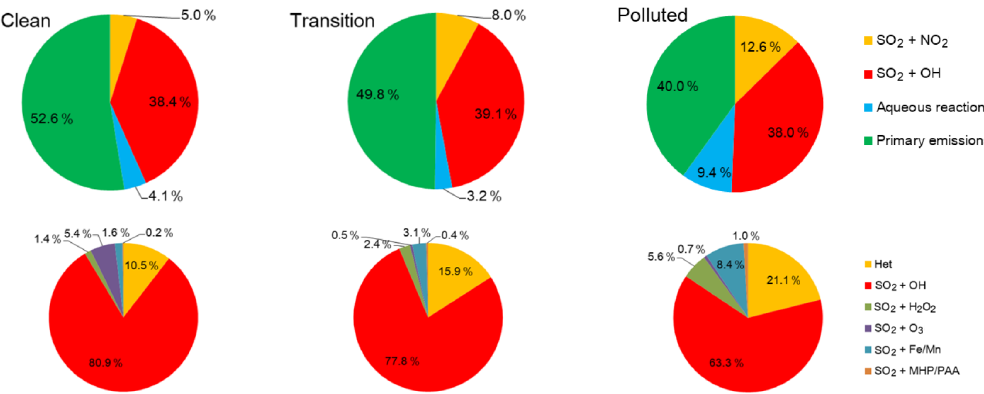
Figure 7. Relative contribution of different pathways to sulfate concentrations at the SAES site during clean, transition, and polluted periods. Primary sulfate emissions were excluded in the bottom row.